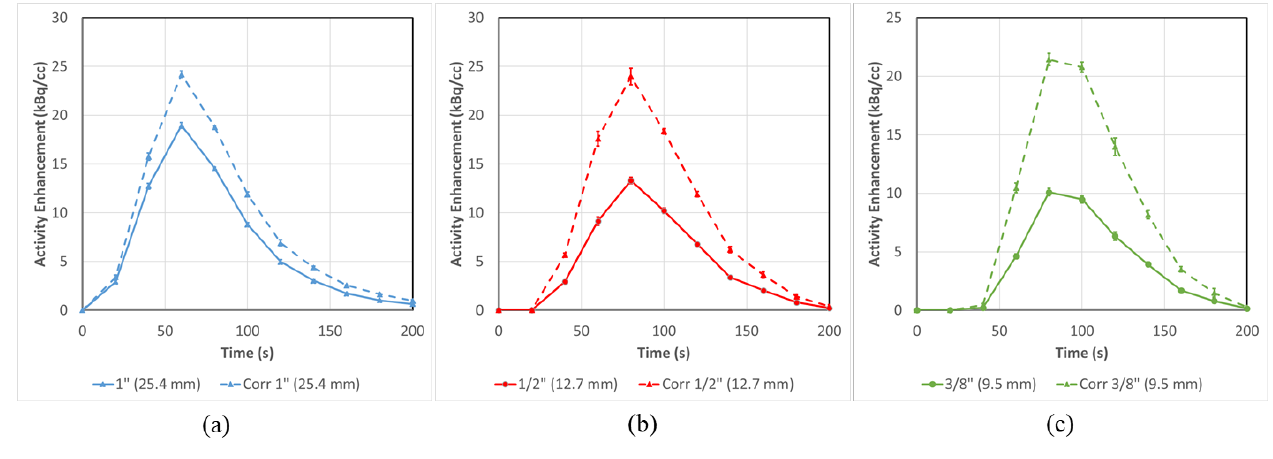
Figure 6. Mean input function activity can be successfully corrected for flow tubes ( a ) 1” (25.4 mm), ( b ) ½” (12.7 mm) and ( c ) 3/8” (9.5 mm) in a situation with no background. All three tubes are corrected to varying degrees with smaller tubes having larger corrections (42 ± 4% for 3/8”) than the large ones (21 ± 3% for 1”) in terms of AUC Error bars represent the standard error from multiple ROI regions (n = 5).